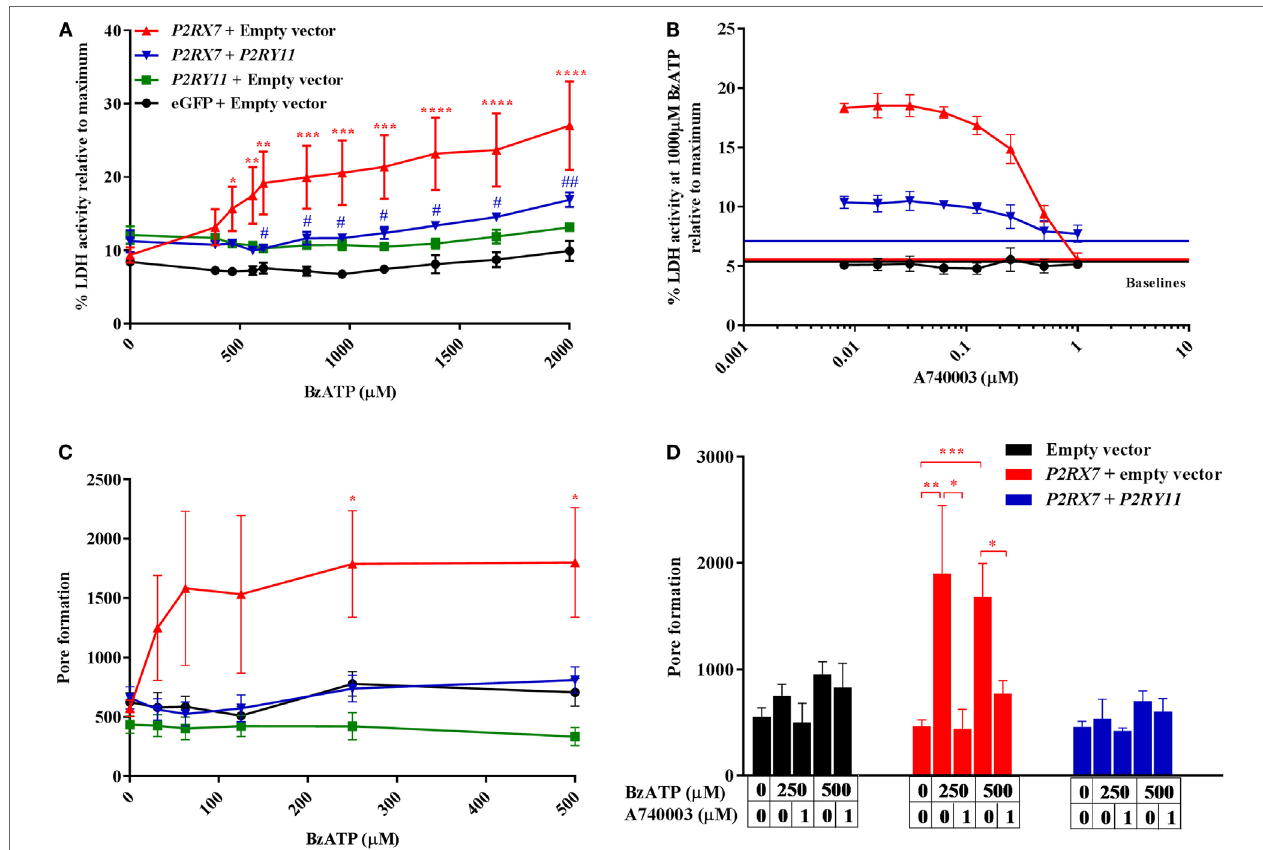
FigUre 5 | P2X7-mediated cell death and pore formation are lower when cells are cotransfected with P2RY11 . Top row: the activity of lactate dehydrogenase (LDH) in the supernatant after 2 h in human embryonic kidney-293 (HEK-293) cells transiently transfected with vectors expressing purinergic receptors. Cells were stimulated with (a) increasing doses of BzATP, n = 5–6 from three experimental runs or (b) 1,000 µM BzATP in combination with various concentrations of P2X7 receptor antagonist, A740003, n = 6–8 from five experimental runs. Data are shown as mean ± SEM of maximum-induced cell death by 1% Triton X-100. LDH baseline activity is shown as solid lines for eGFP + empty vector (black), P2RX7 + empty vector (red), and P2RX7 + P2RY11 (blue), respectively. Bottom row: GripTite cells transiently transfected with vectors expressing purinergic receptors were stimulated with various concentrations of BzATP to induce pore formation measured as YO-PRO-1 fluorescent dye uptake. Cells were stimulated with (c) increasing doses of BzATP, n = 12–29 from nine experimental runs or (D) BzATP and P2X7 receptor antagonist, A740003, n = 6–15 from five experimental runs. Data are shown as mean ±